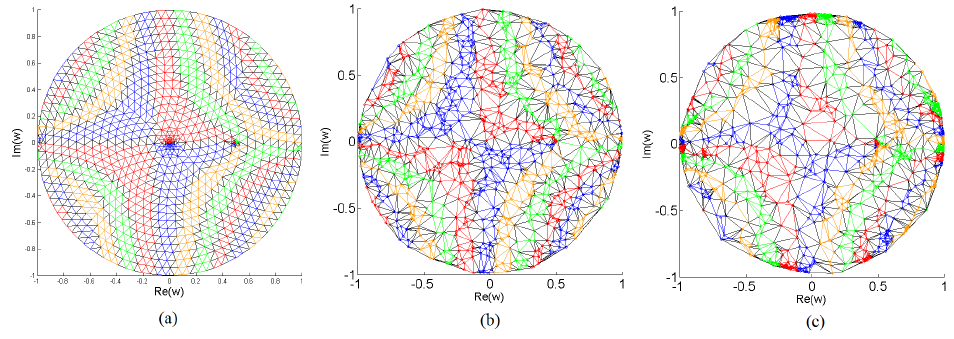
Figure 6. Distribution of nodes with Delaunay’s triangulation in final iteration for ( a ) the GRPF, ( b ) MGA- WPA, and ( c ) MPSO-WPA methods. The stability tests of a high-order system with L = 40 are